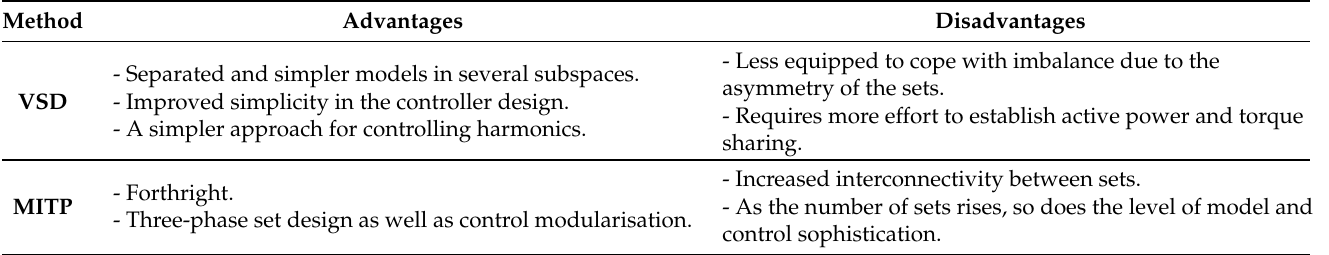
Table 1. Advantages and disadvantages of VSD and MITP models. Method Advantages